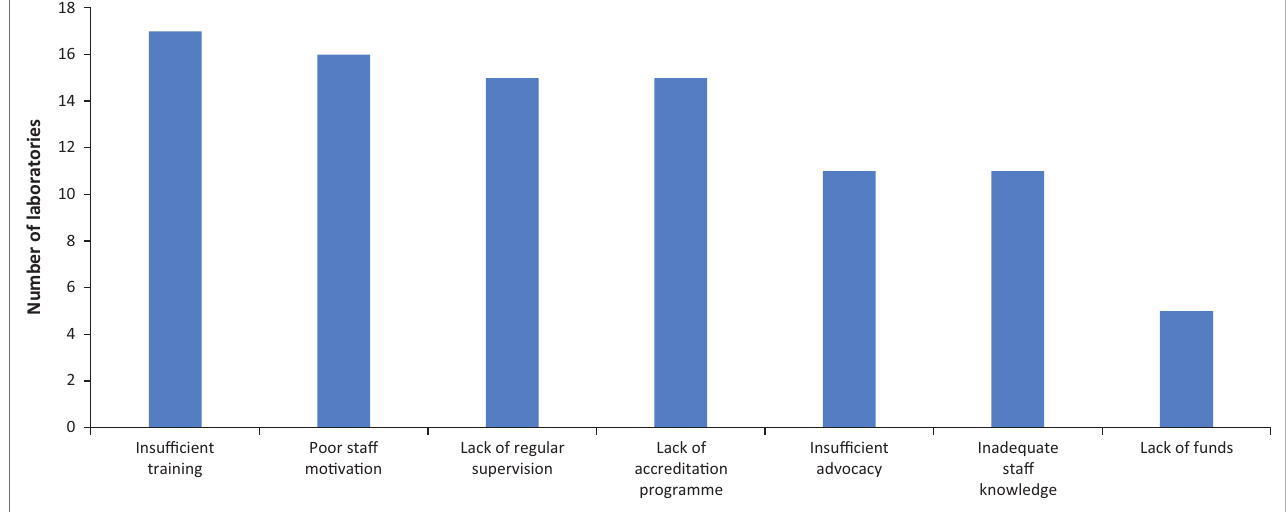
† , Data are from 20 NTRLs in the World Health Organization’s African Region that reported not working towards accreditation and provided one or more reasons. Individual laboratories provided more than one response. FIGURE 5: Reasons reported by National Tuberculosis Reference Laboratories in the World Health Organization African Region † for not currently working towards